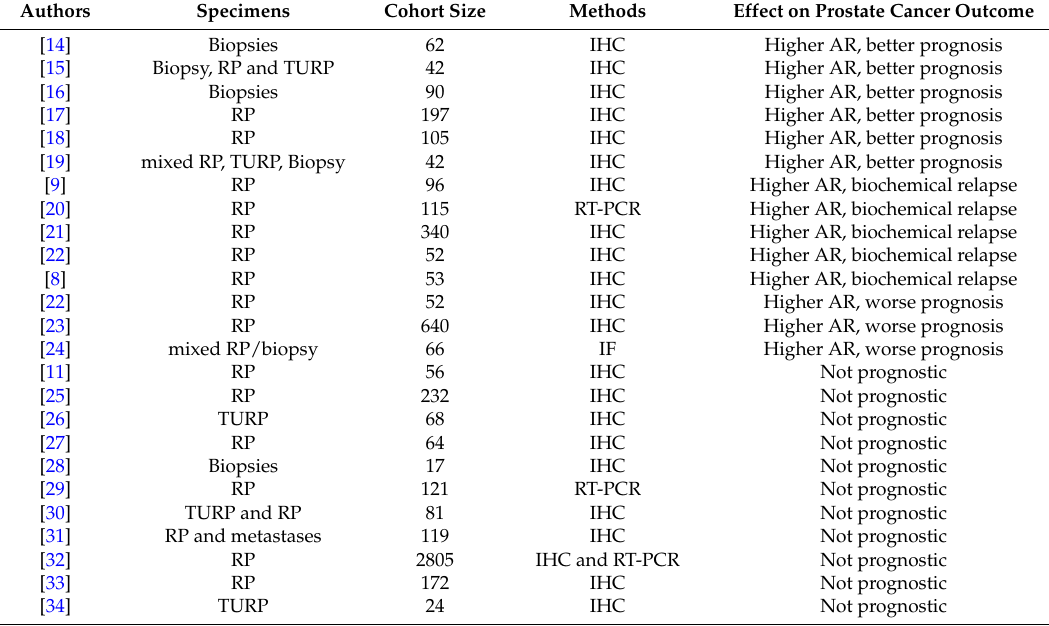
Table 1. Expression of AR in cancerous epithelial tissue and association with outcomes. RP = Radical RT-PCR = Real time polymerase chain